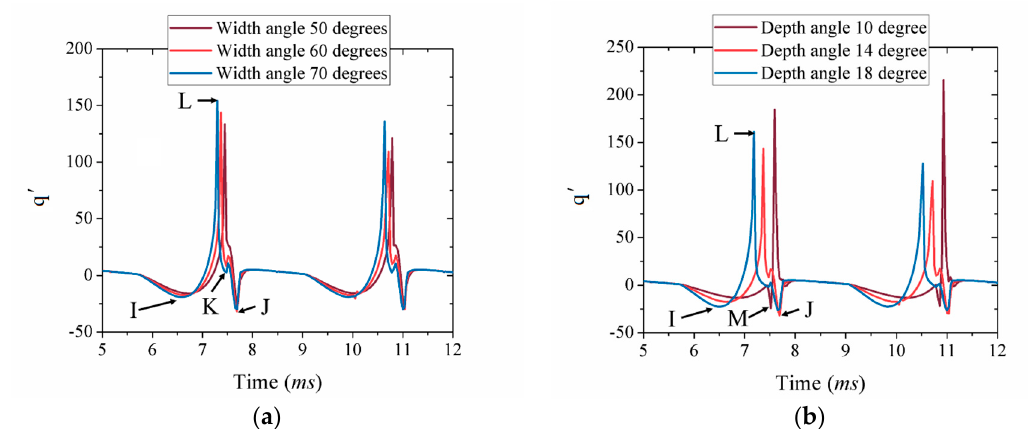
Figure 10. The Figure shows the variations of flow discordance: ( a ) flow discordance of varied width angles; ( b ) flow discordance of varied depth angles.